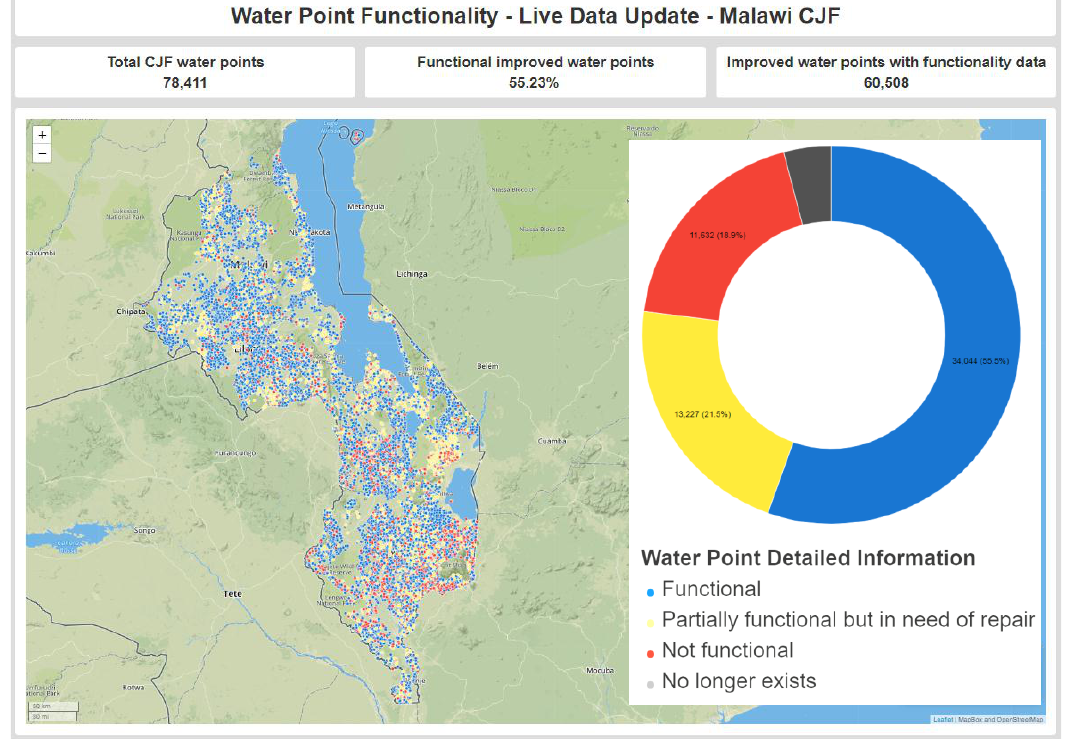
Figure 2. Results of site surveys to evaluate functional status of rural water supplies as presented by the mWater Management Information System (MIS).